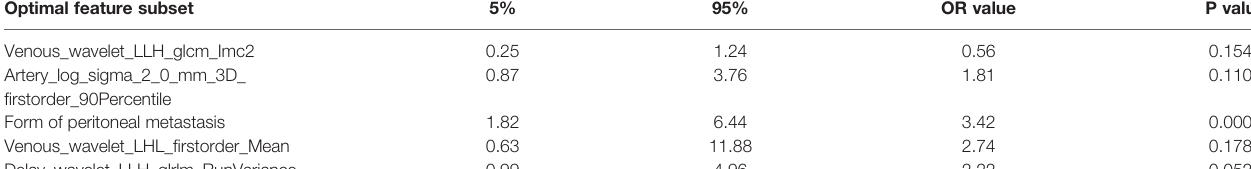
TABLE 4 | Multifactorial analysis of correlations: CT features and texture features vs. BRCA mutation status. Optimal feature subset